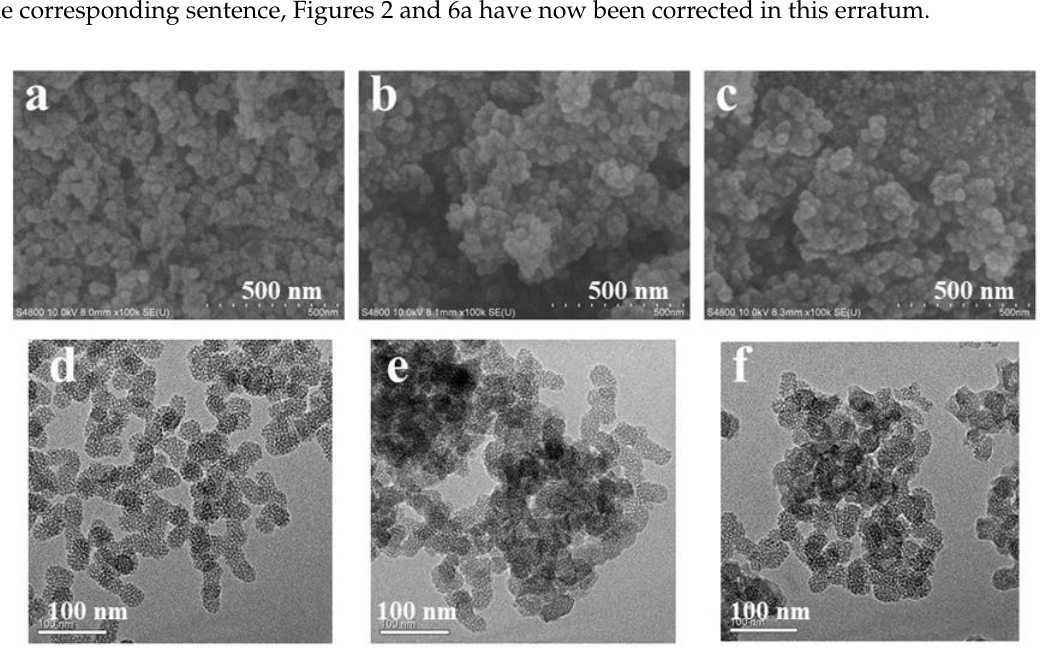
Figure 2. SEM images of ( a ) MSN, ( b ) MSN-PEI, and ( c ) MSN-PEI-FA; the TEM images of ( d ) MSN, ( e ) MSN-PEI, and ( f ) MSN-PEI-FA.